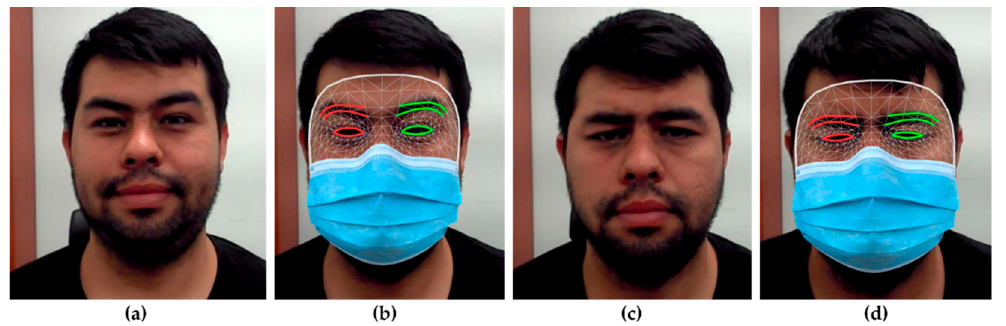
Figure 9. Results of facial landmark detection. ( a ) Happiness emotion; ( b ) landmark detection on masked face emotion; ( c ) sadness emotion; ( d ) landmark detection on masked face.